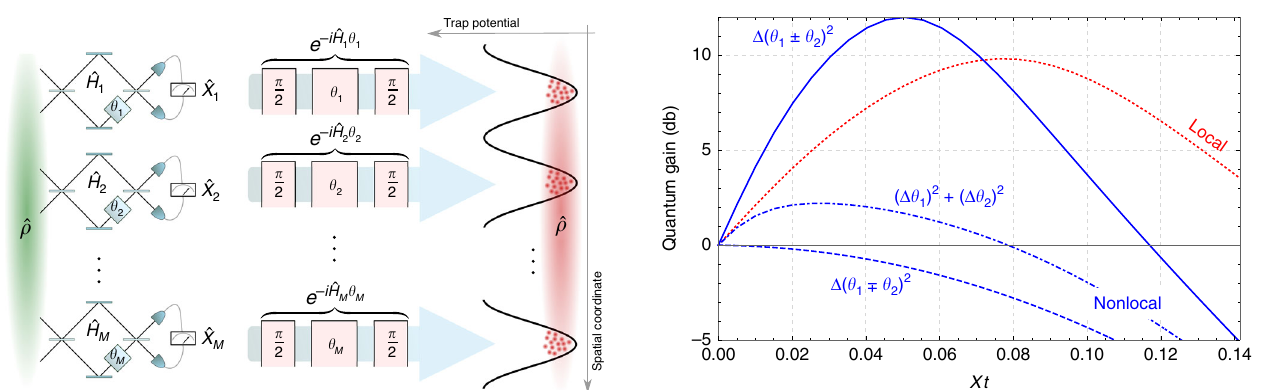
Fig. 1 Quantum-enhanced parallel interferometers. In each mode k = 1, … , M of a set of Mach – Zehnder (left) or Ramsey interferometers (right), a single parameter θ k is imprinted by a local Hamiltonian ^ H k , and a local observable ^ X k is measured. The multiparameter sensitivity is quanti fi ed by the moment matrix (Eq. (2)). The multiparameter quantum gain is captured by the squeezing matrix (Eq. (10)), which contains both local (single- parameter) enhancements and nonlocal (multiparameter) squeezing. The sensitivity can be optimized analytically using Eq. (6) and the maximum is achieved when Eq. (9) is ful fi lled for a set of commuting observables ^ X